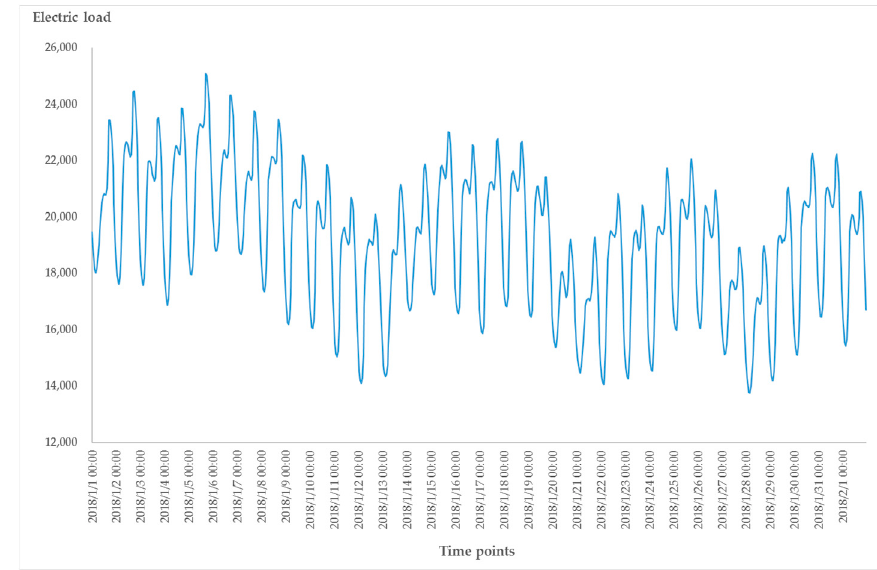
Figure 9. The seasonal tendency of actual hourly electric load in Example 2. Table 6. The 24 seasonal indexes for SVRCCS and SVRCS models for Example